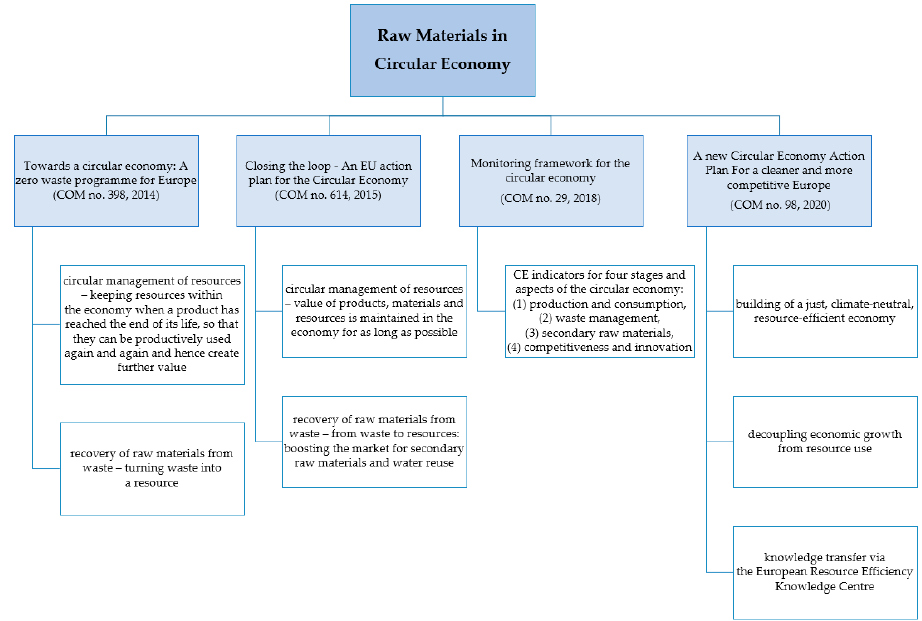
Figure 2. Inventory of the key EU documents on the CE implementation. Source: own based on [4–6,33].